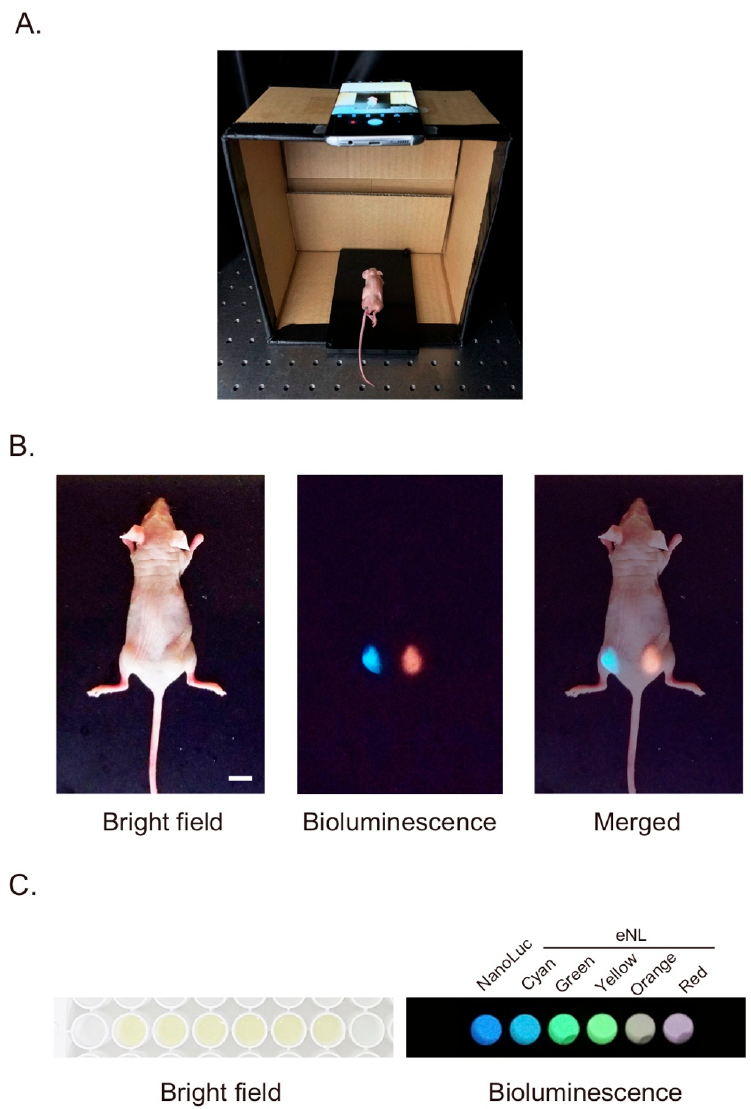
Figure 1. Simultaneous multiple wavelength bioluminescence imaging using a smartphone camera. ( A ) Imaging setup: a cardboard box was used as a stand for the smartphone. ( B ) Whole body